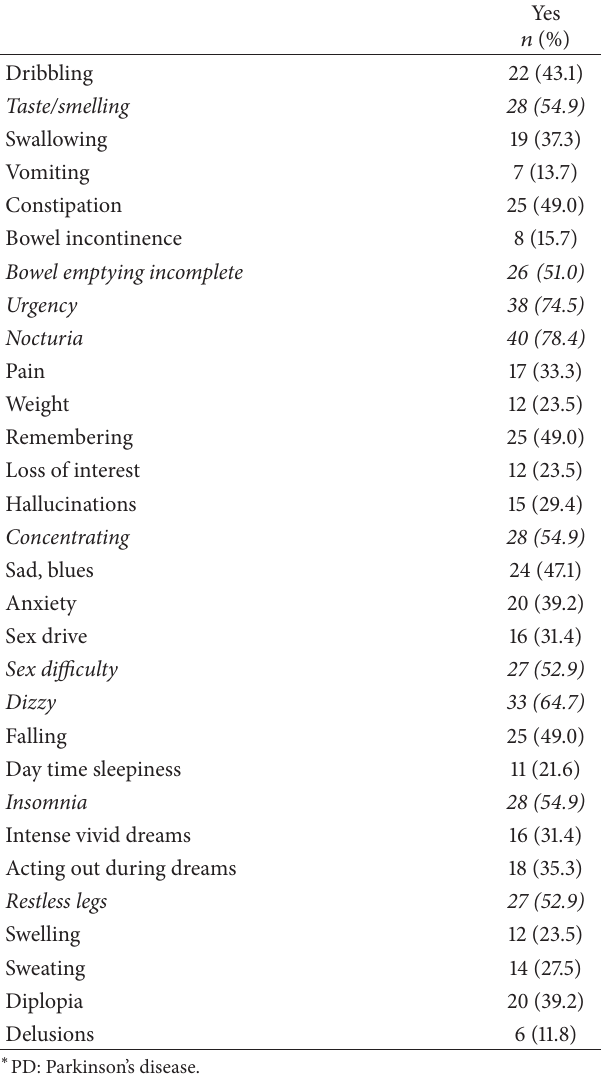
Table 2: PD-patients ∗ self-rated frequency of non-motor symp- toms. 𝑛 = 51